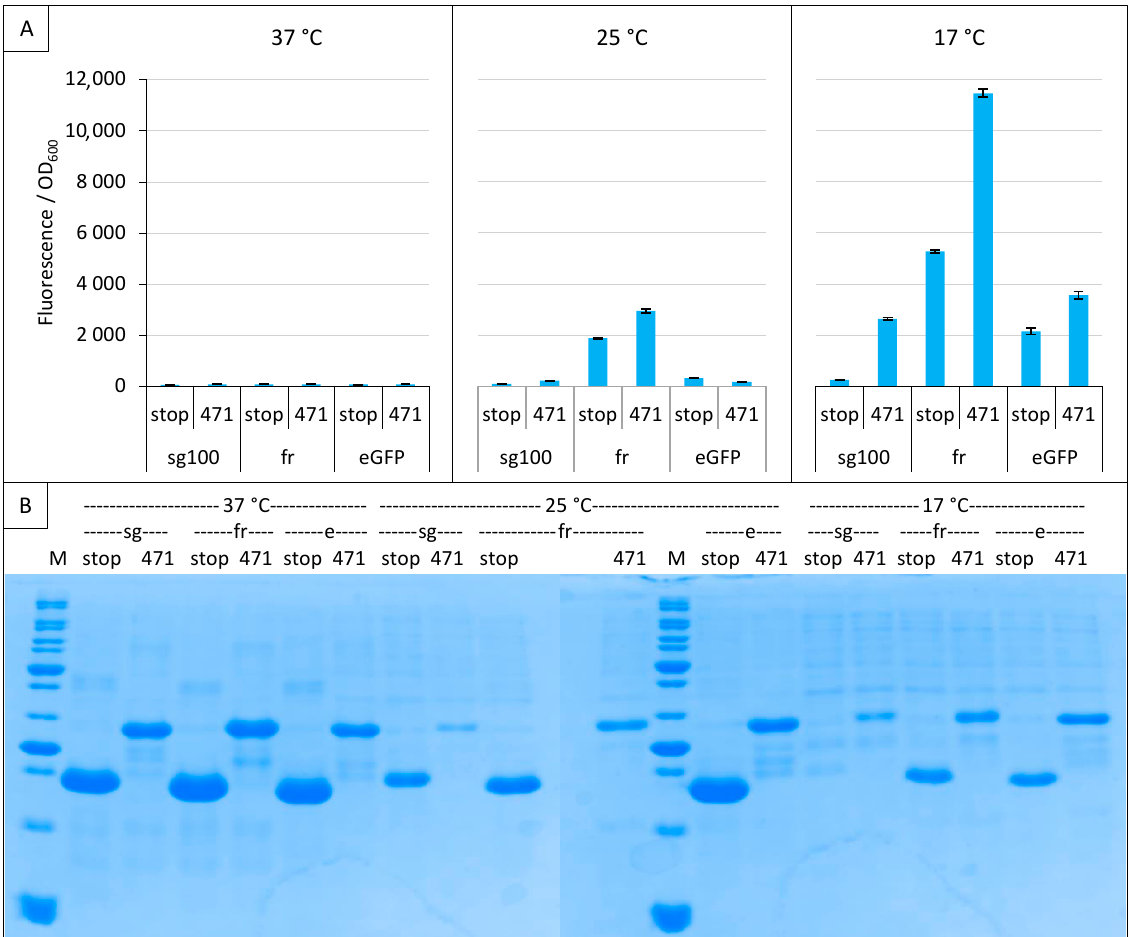
Figure 4. Comparison of sg100, fr and sp GFP variants at different temperatures . Split-GFP reassem- bly assay results as obtained with the negative (stop) and positive (471) controls of the 471/XD in- teraction with sg100, fr and sp GFP reporters at 37 °C, 25 °C and 17 °C. The interaction between leucine zippers (LZ) is included for sg100 and sp. ( A ) Fluorescence to OD 600 ratios. ( B ) SDS-PAGE analysis of the expression of the NGFP fusions. M, molecular size markers (200, 150, 100, 85, 70, 60, 50, 40, 30, 25, 20, 15, 10 kDa). We next tested the enhanced GFP (eGFP). Figure 5A shows that eGFP optimal tem- perature is also 17 °C, but even at that temperature eGFP did not reach the fluorescence signal of fr nor the SNR of sg100 (10.6 for sg100 versus 1.6 for eGFP). Figure 5B shows that NGFP fusions were well expressed even at 37 °C where very low fluorescence values were observed.